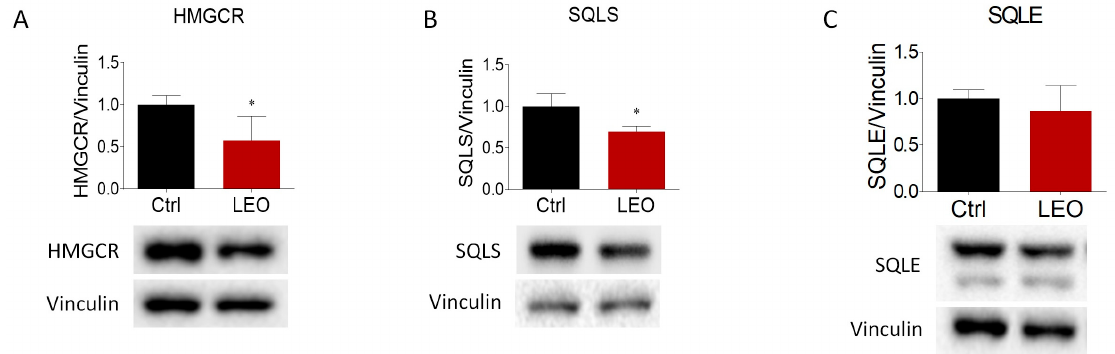
Figure 2. Effects of LEO administration on the main proteins involved in cholesterol biosynthesis. Representative Western blot and densitometric analysis of ( A ) HMGCR, ( B ) SLQS, and ( C ) SQLE proteins in HepG2 cells treated with the vehicle (DMSO, Ctrl cells) and LEO (0.005%) for 24 h. Vinculin was chosen as the loading control. n = 3 independent experiments. Data represent means ± SD. Statistical analysis was performed using the unpaired Student’s t -test. * p <